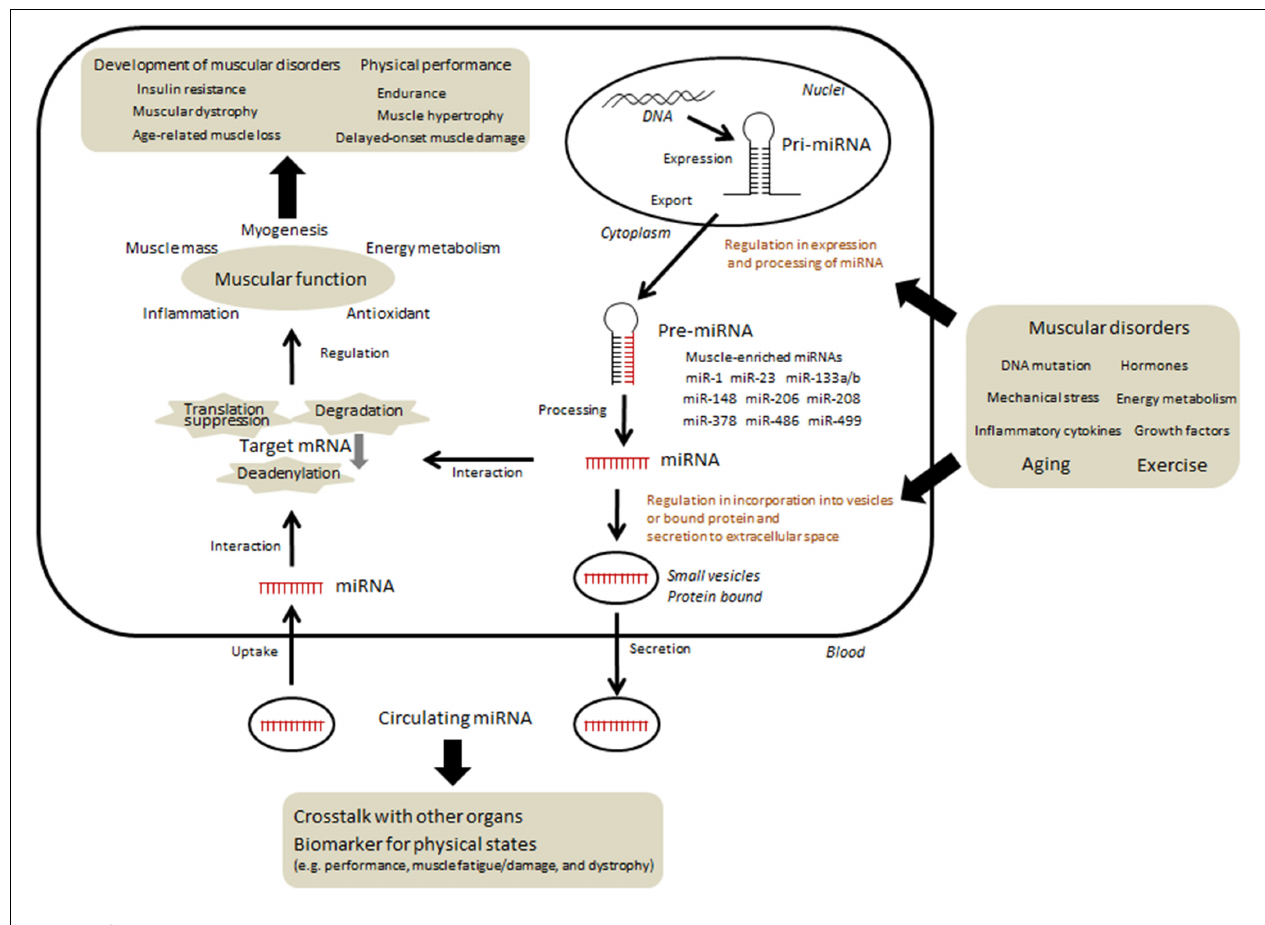
metabolism. Some of miRNAs can be taken up into intracellular vesicles and secreted into extracellular fluid. Circulating miRNAs migrate to skeletal muscle as well as other organs and may regulate certain functions. In addition, specific c-miRNAs may be useful in determining precise muscle-related